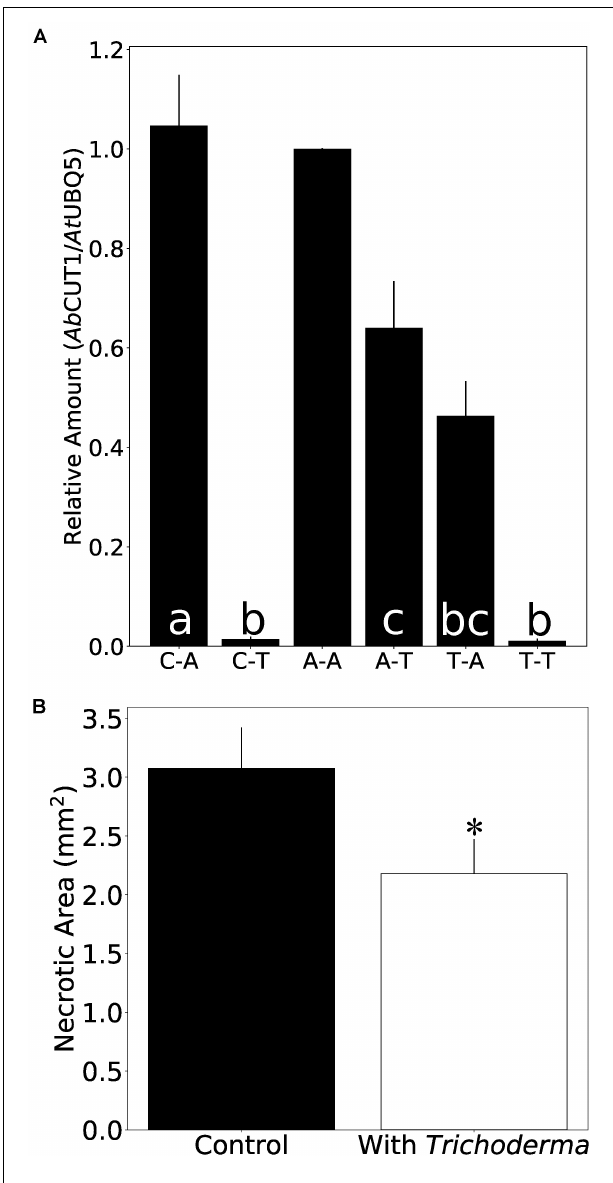
FIGURE 7 | Trichoderma protects Arabidopsis seedlings against A. brassicicola infection. (A) Amount of A. brassicicola CUT1 DNA relative to A. thaliana UBQ5 DNA in root tissue. C-A: co-cultivation with control plug for 7 days, then co-cultivation with A. brassicicola for another 7 days. C-T: co-cultivation with control plug for 7 days, then co-cultivation with Trichoderma for another 7 days. A-A: co-cultivation with A. brassicicola for 7 days, then co-cultivation with A. brassicicola for another 7 days. A-T: co-cultivation with A. brassicicola for 7 days, then co-cultivation with Trichoderma for another 7 days. T-A: co-cultivation with Trichoderma for 7 days, then co-cultivation with A. brassicicola for another 7 days. T-T: co-cultivation with Trichoderma for 7 days, then co-cultivation with Trichoderma for another 7 days. Values from qPCR experiment were normalized to A-A. Error bars represent SEs from three independent biological replicates, each with 6–9 seedlings. Statistical significance was determined by Tukey’s HSD test with P < 0.05, and is indicated by different lower-case letters. (B) Necrosis area on leaflets infected by A. brassicicola. Error bars represent SEs from 35 independent biological replicates. Statistical significance was determined by Welch Two Sample t -test ( ∗ P < 0.05).